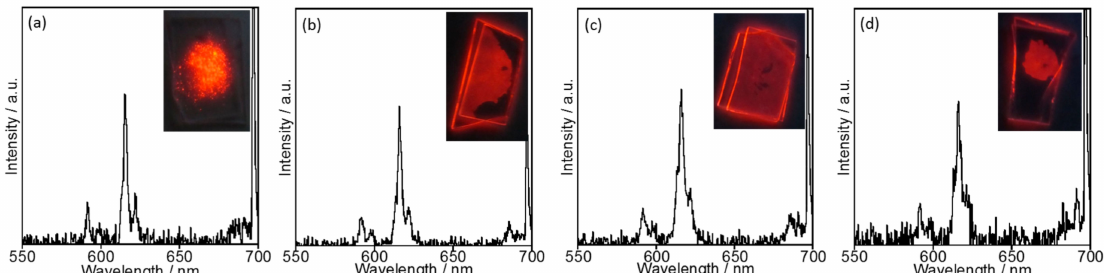
Figure 8. In situ temperature dependence of emission spectra with photographs of EuL in [EMIM][PF 6 ] at ( a ) 17, ( b ) 61, ( c ) 108, and ( d ) 121 ◦ C ( λ ex = 254